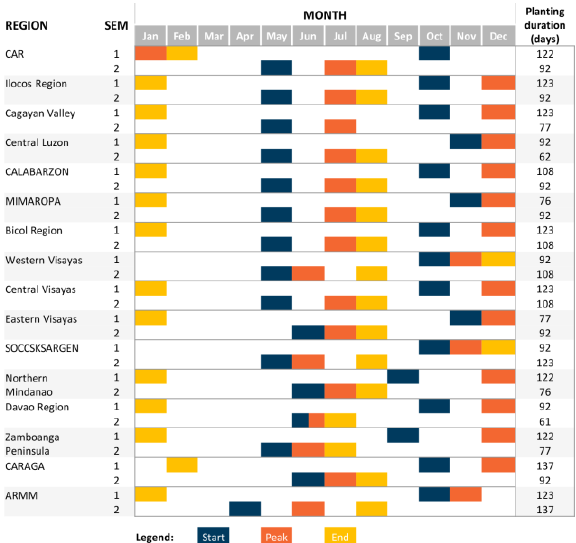
Figure 6. Start, peak and end of planting and duration of planting dates by semester and region in the Philippines, 2016-2018.